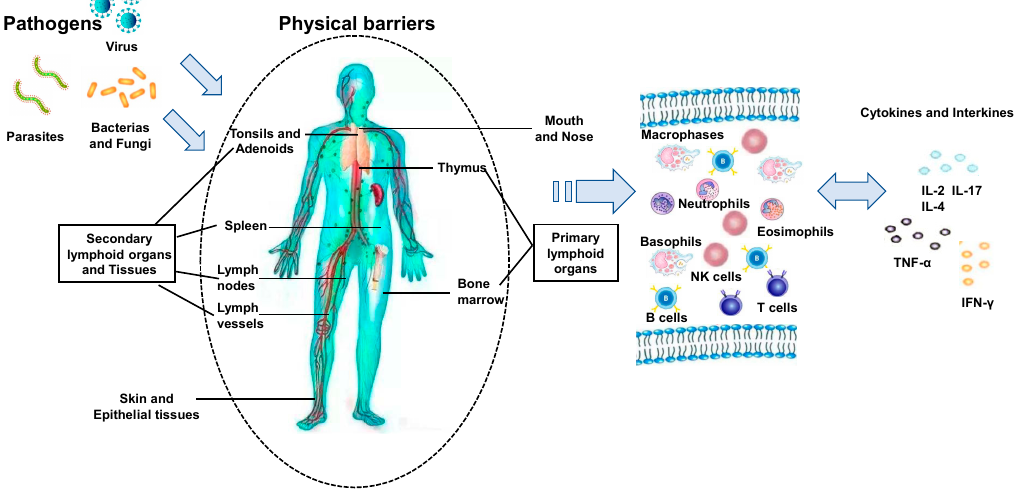
Figure 3. Key components and pathways in host immune response against pathogen infections.